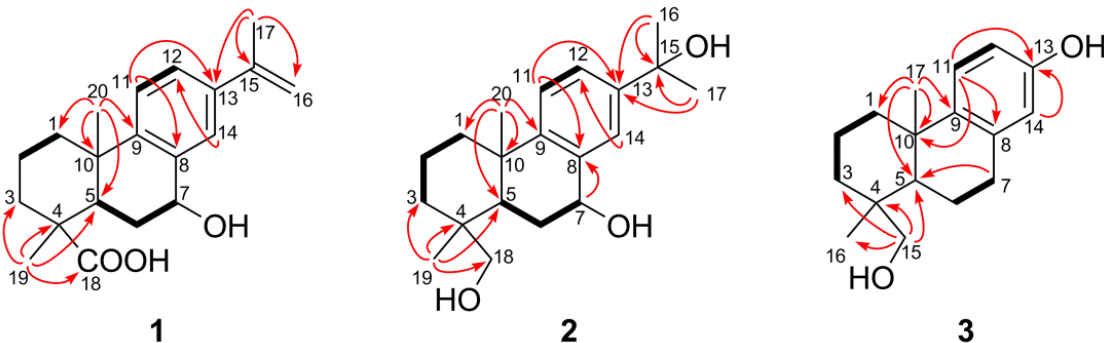
Figure 2. Key 1 H– 1 H COSY ( ▬ ) and HMBC (H → C) correlations of compounds 1 – 3